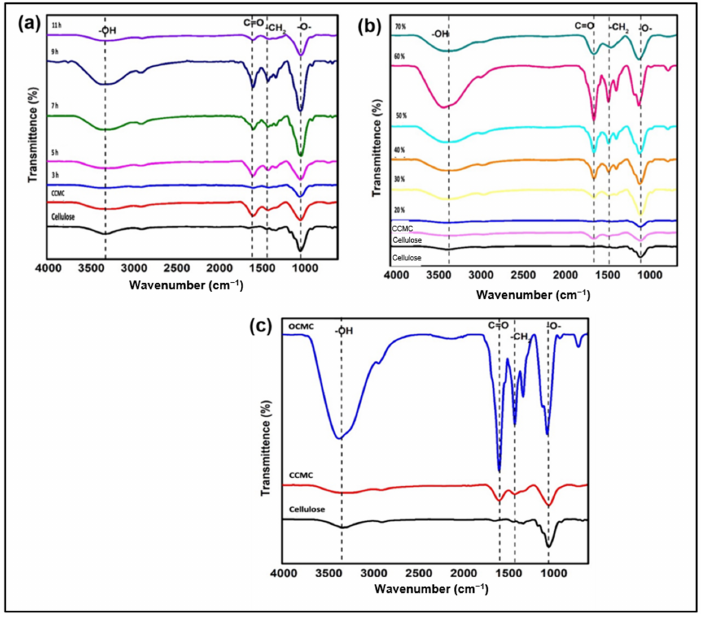
Figure 5. FTIR spectra of OCMC synthesized with various alkalization times ( a ); OCMC synthesized with various concentrations of NaOH solution ( b ); Comparison of cellulose, CCMC, and OCMC synthesized at 9 h with 60% NaOH solution ( c ).